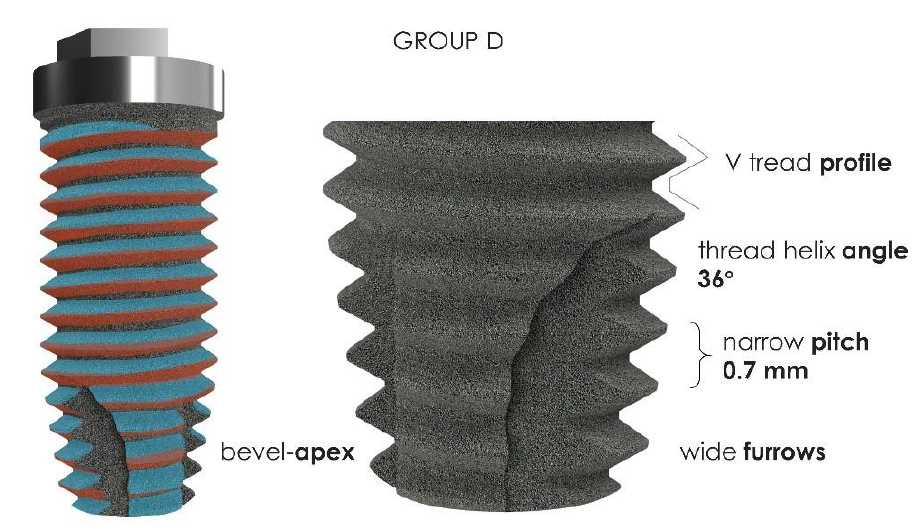
Figure 3. Group C: in detail, the morphology and thread geometry of the cylindrical implants.